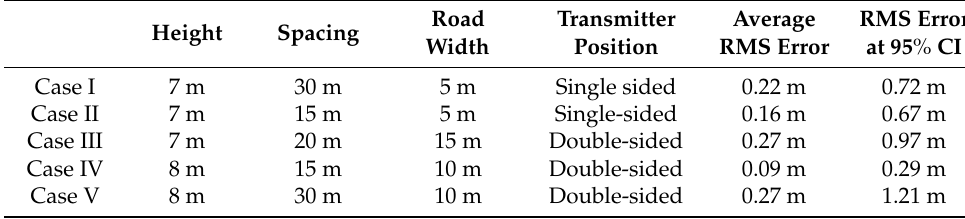
Figure 9. CI analysis over 100 positions across the road. Table 4. Different road dimensions in urban